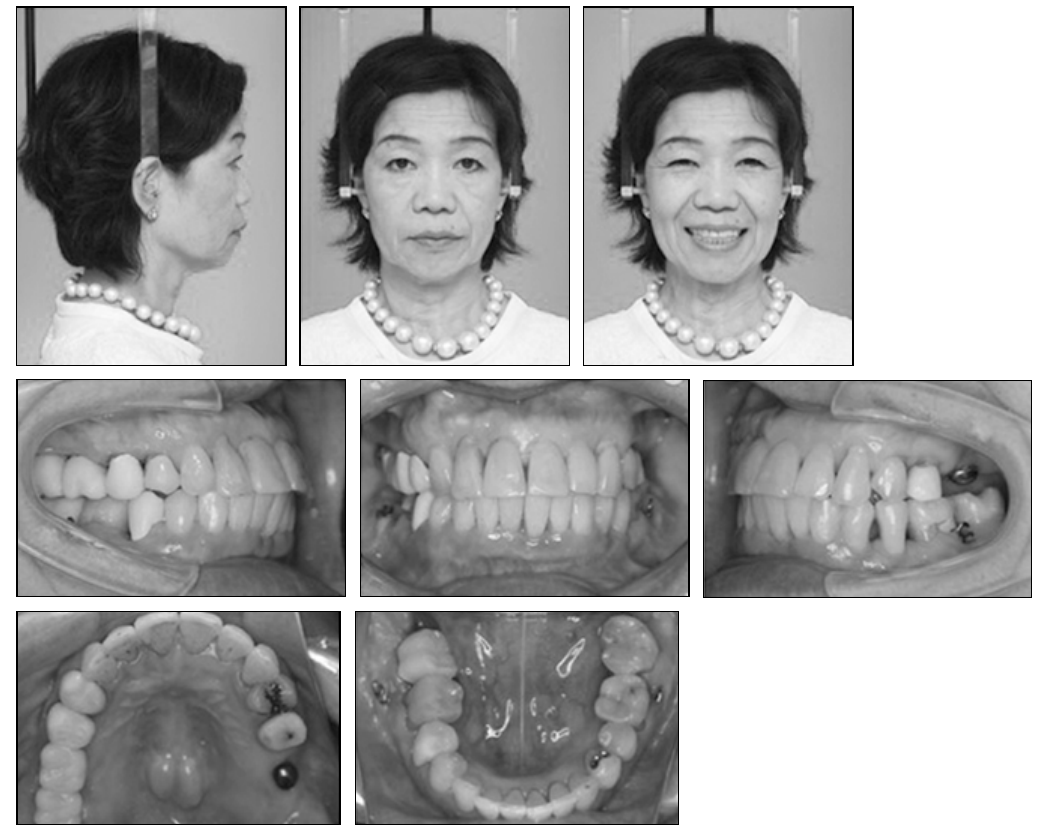
Figure 6. Facial and intraoral photographs at the end of the active orthodontic